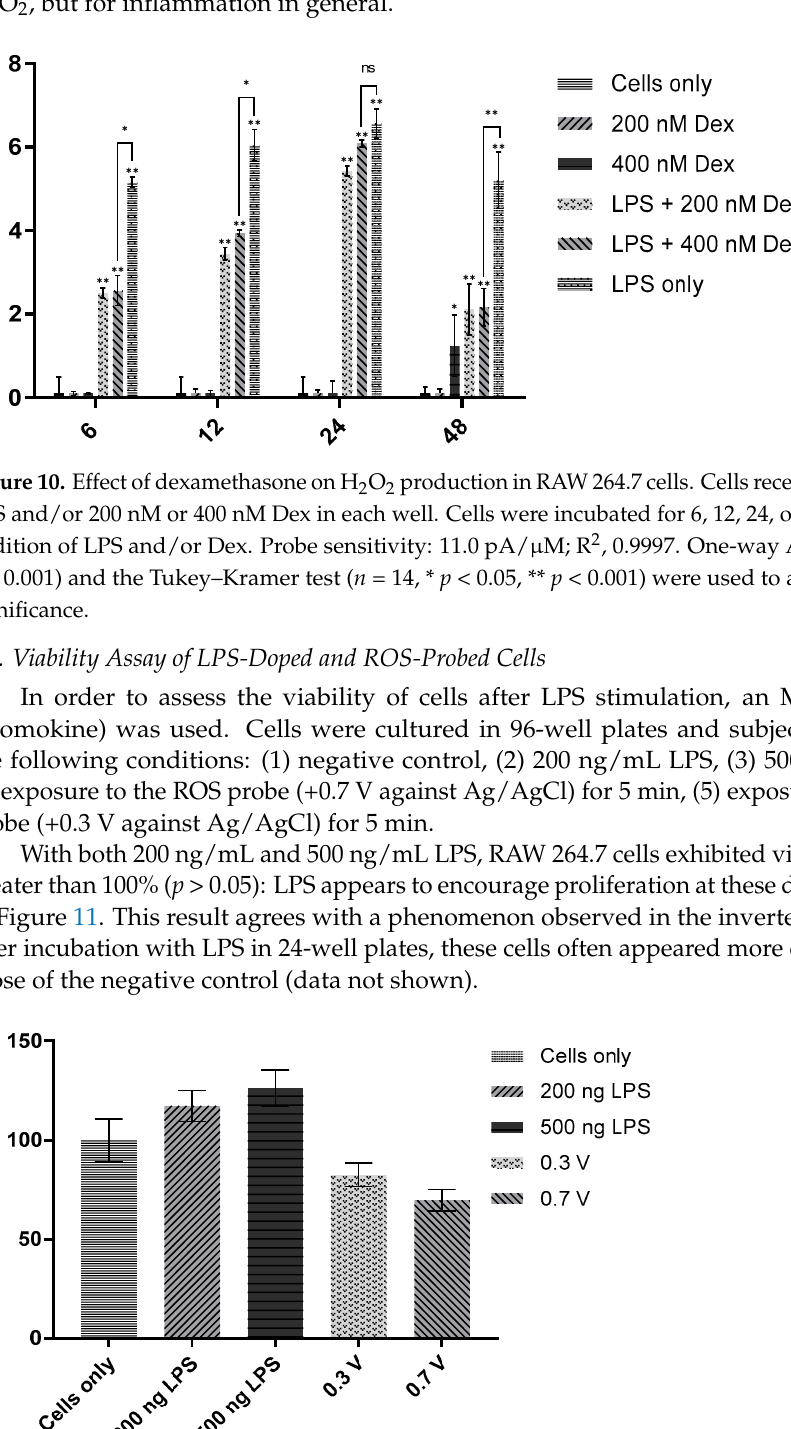
11 of 14 Figure 9. Effect of reduced incubation temperature on H 2 O 2 production in RAW 264.7 cells. LPS- doped cells received 200 ng/mL in each well. Cells were incubated for 48 h at 4 °C or 37 °C (5% CO2) following addition of LPS. Probe sensitivity: 11.0 pA/µM; R 2 , 0.9997. One-way ANOVA ( n = 8, p < 0.001) and the Tukey–Kramer test ( n = 14, ** p < 0.001) were used to assess statistical significance. H 2 O 2 was significantly elevated when LPS-doped cells were incubated at 37 °C, whereas little or no H 2 O 2 were detected for cells incubated at 4 °C, thus supporting the metabolic energy dependence of H 2 O 2 production in LPS-activated macrophages.